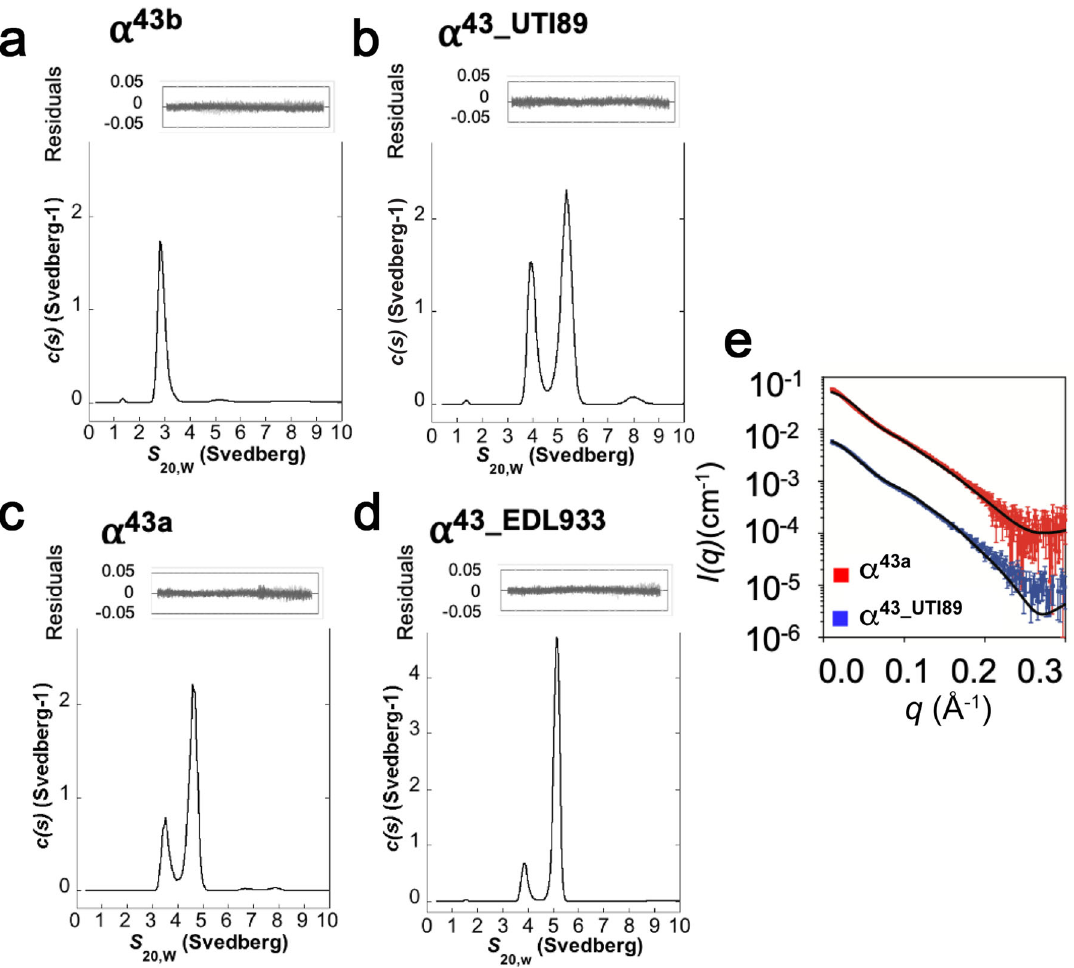
Fig. 5 Oligomeric state of Ag43 variants in solution. Representative analytical ultracentrifugation (AUC) sedimentation velocity analysis of the Ag43 variants at 2.2 mg/mL with c ( s ) plotted as a function of s 20,w (Svedberg). Both α 43a c and α 43_EDL933 d showed a much higher proportion of dimer (4.7 and 5.2 S) than monomer (3.5 and 3.8 S). In comparison α 43_UTI89 b revealed a higher proportion of monomer (3.9 S) than dimer (5.4 S), whereas α 43b a showed only a monomeric species (2.8 S). Residuals resulting from the c ( s ) distribution fi ts are shown above. Small-angle X-ray scattering measurements of α 43a (red) and α 43_UTI89 (blue) in solution e . Model scattering curves are overlayed on the experimental data (solid black line) and have been calculated as a linear combination of monomer and dimer scattering curves. The model scattering curves are consistent with the experimental data ( χ 2 ( α 43a ) = 22.9; χ 2 ( α 43_UTI89 ) =